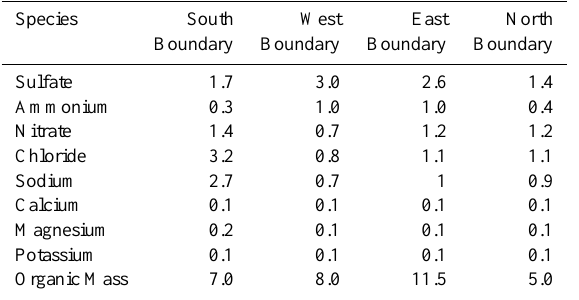
Table 1. Aerosol concentrations (µgm − 3 ) at the boundaries of the domain.